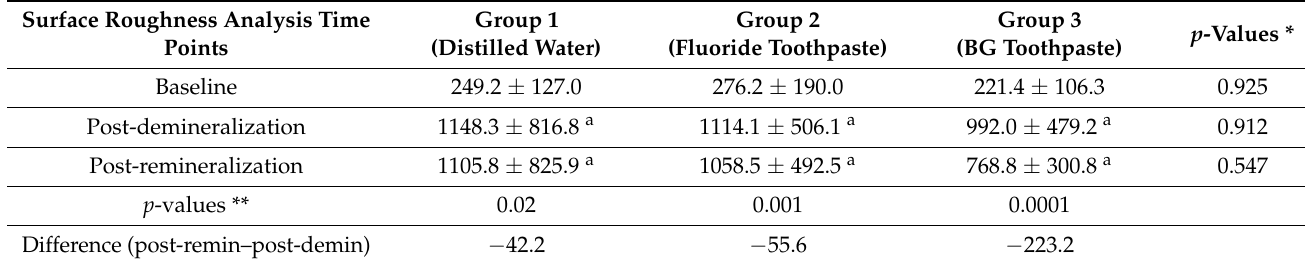
Table 2. Showing mean ± SD Ra (nm) for the three groups at different analysis time points.